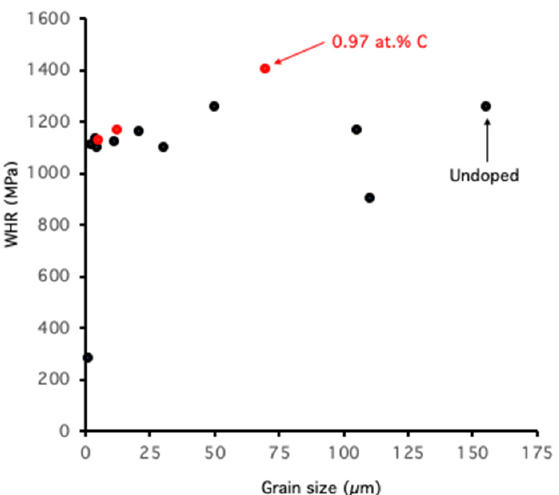
Figure 7. Work Hardening Rate (WHR) at room temperature versus grain size for undoped equiatomic CoCrFeMnNi—black points—(calculated from [18–20,28]), and for 0.97 at. % carbon doped CoCrFeMnNi—red points (calculated from [21]).